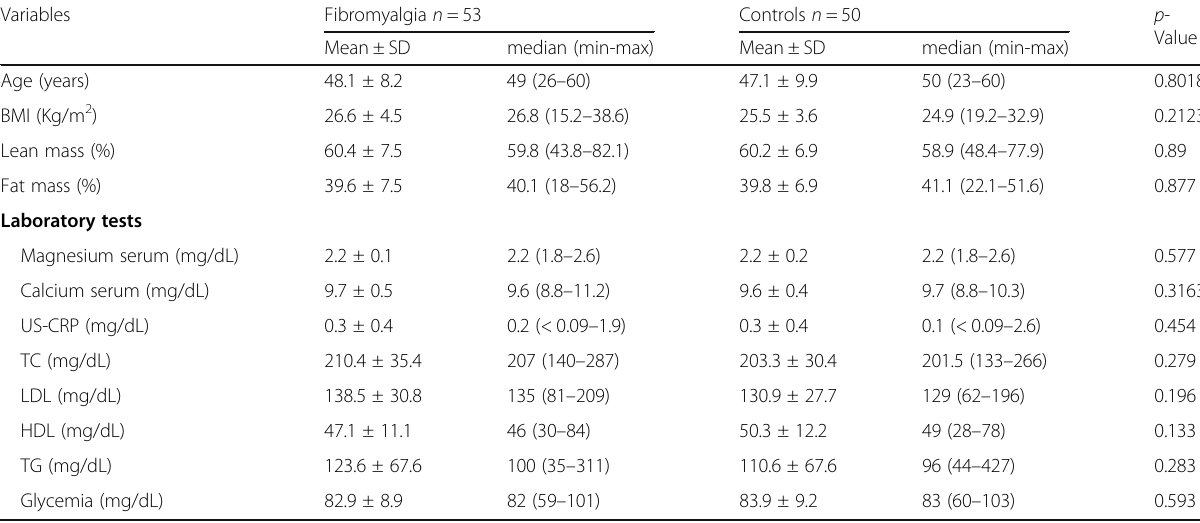
Table 1 General characteristics of the participants with fibromyalgia and controls